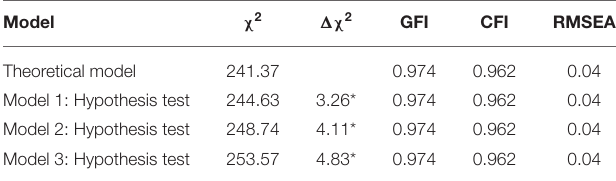
TABLE 2 | Nested model